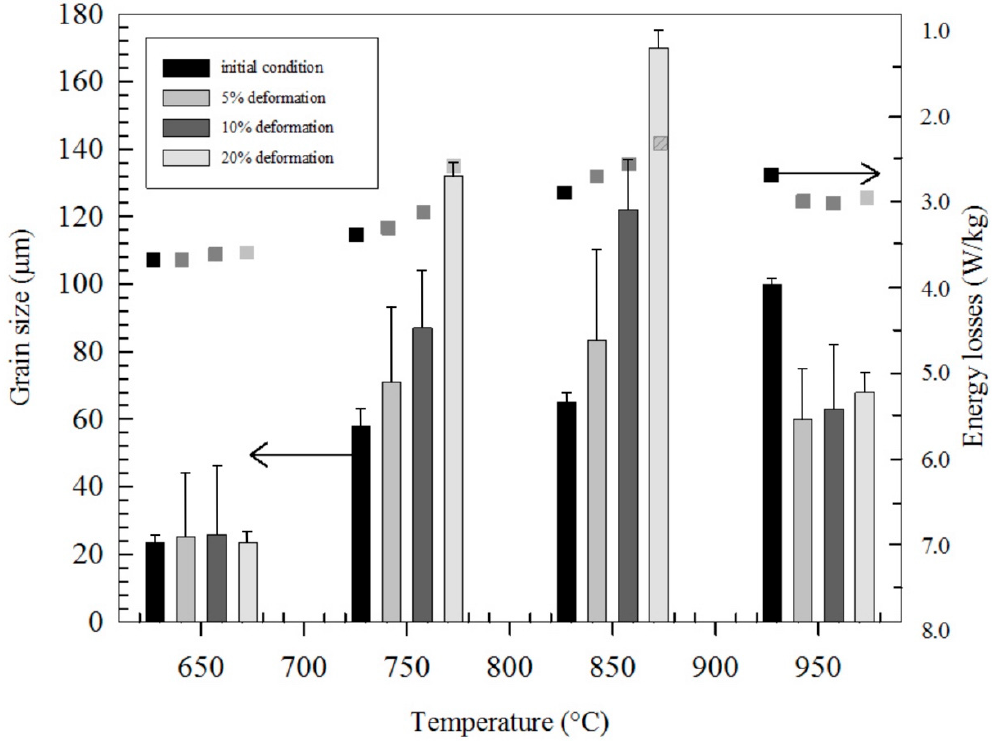
Figure 7. Effect of annealing temperature on grain size-energy losses relationship in deformed electrical steel samples. → energy losses, ← grain size.